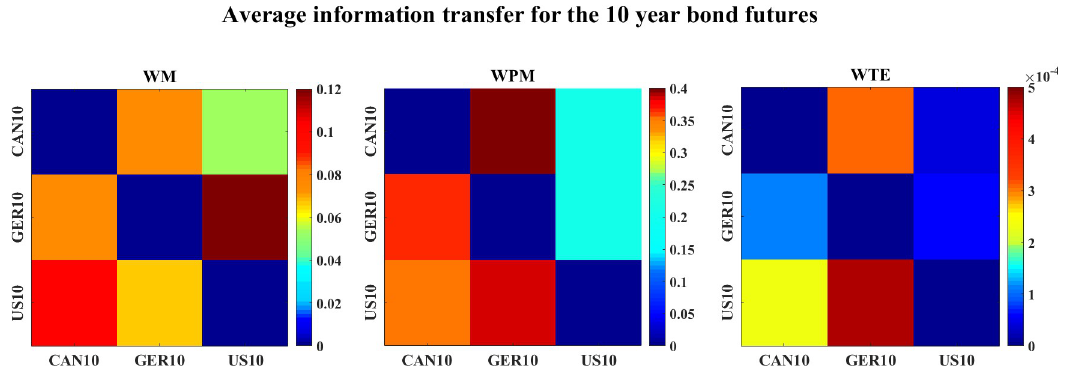
Fig 31. The color-map for the average information transfer values of the 10-year bond futures. The three color-graphs present the color-map for the average WM (left), WPM (middle) and WTE (right) values for the 10-year bond futures. The direction of interaction is read from the row channel to the column channel for each lattice.